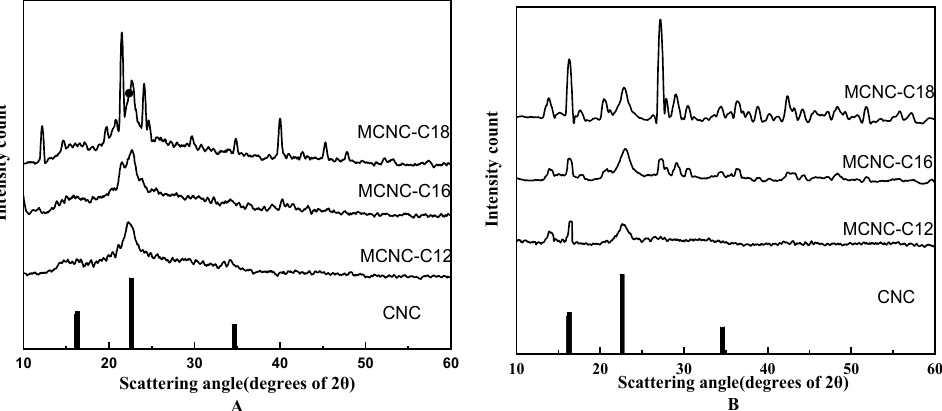
Figure 5. X-ray diffraction pattern of fatty acid MCNC. ( A : diffraction curve of MCNC crystal prepared by esterification method, and B : diffraction curve of MCNC crystal prepared by graft copolymerization method).